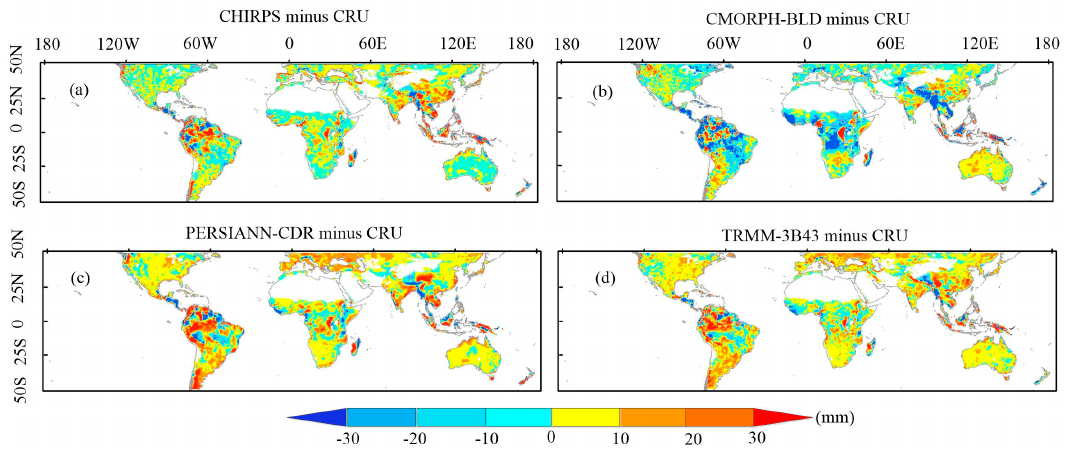
Figure 1. Spatial distributions of mean monthly precipitation differences between Climate Research Unit (CRU) gauge observations against the Quantitative Precipitation Estimation (QPE) product estimates from 2000 to 2016 ( a – d ).